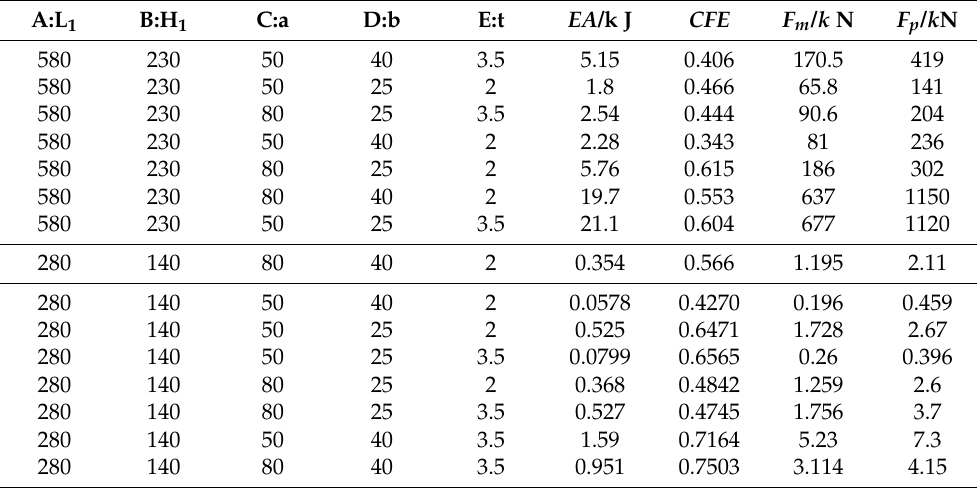
Table 5. Influence of interface morphology on material